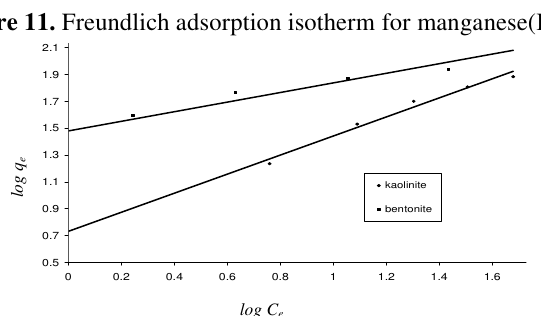
Figure 12. Freundlich adsorption isotherm for nickel(II) Table 10. Freundlich and Langmuir constants for manganese(II)